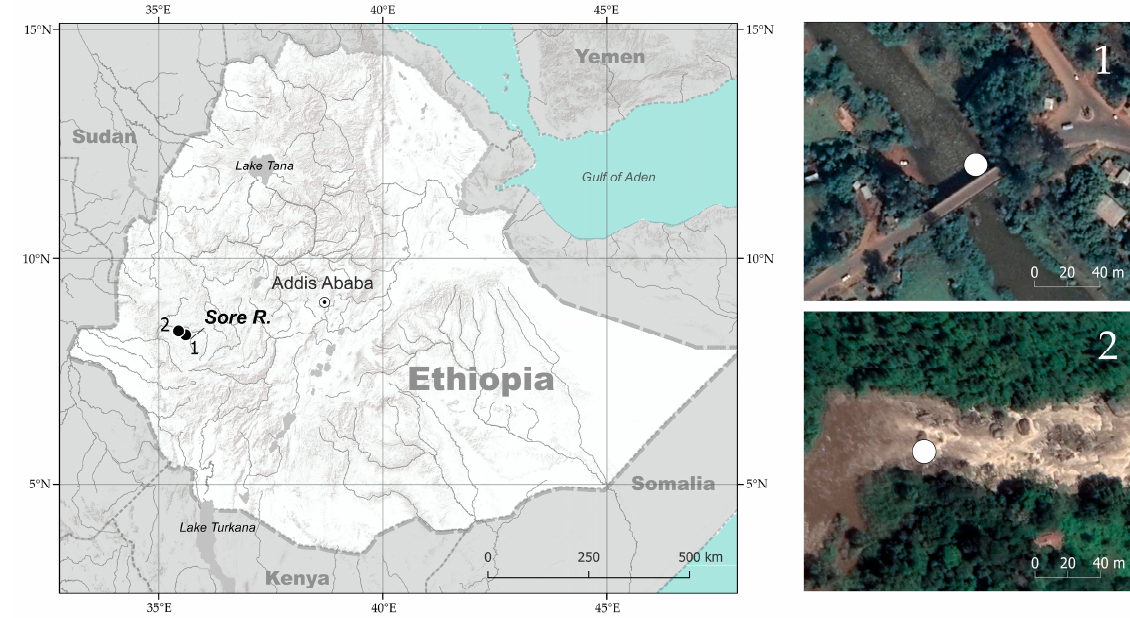
Figure 2. Map with sampling sites of Garra in the Sore River, White Nile basin, East Africa (left); satellite images of the riverine segments with certain sampling points (right). The map was created using QGIS v.3.16.4-Hannover.